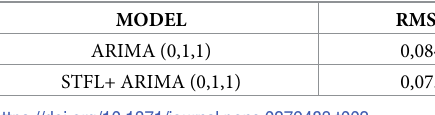
Table 2. Predictive analysis of mortality rate